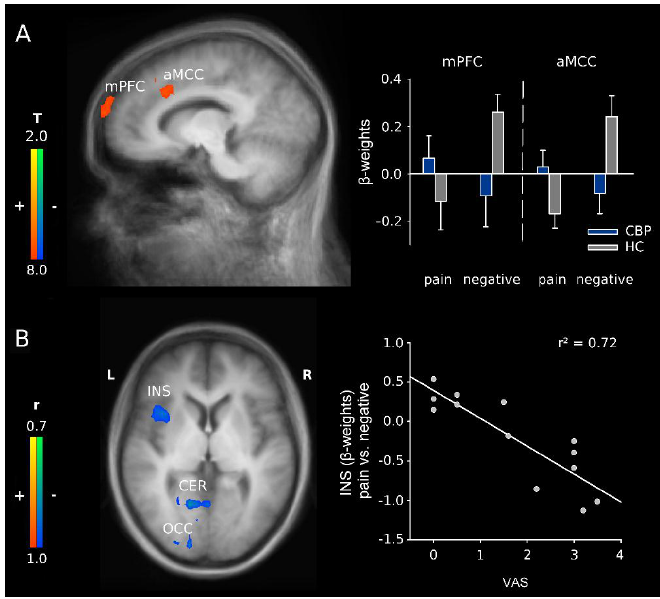
Figure 3. ( A ) activation maps illustrating the interaction between group (CBP patients vs. HC) and word category (pain-related vs. negative adjectives) with activations in the medial prefrontal cortex (mPFC) and anterior midcingular cortex (aMCC) including the dorsolateral prefrontal cortex (DLPFC); x = −10. Right: schematic overview of the β-weights for the aforementioned structures; mean + Standard Error; and ( B ) correlation of current pain (VAS) with the differences in parameter estimates for the contrast pain-related vs. negative adjectives in CBP patients in insula (INS), cerebellum (CER) and occipital cortex (OCC); z = 4. Activations are superimposed on a Talairach template (average of all subjects). Right: correlation plot for the relation of current pain (VAS) and differences in parameter estimates for the contrast pain-related vs. negative adjectives for the anterior insula.